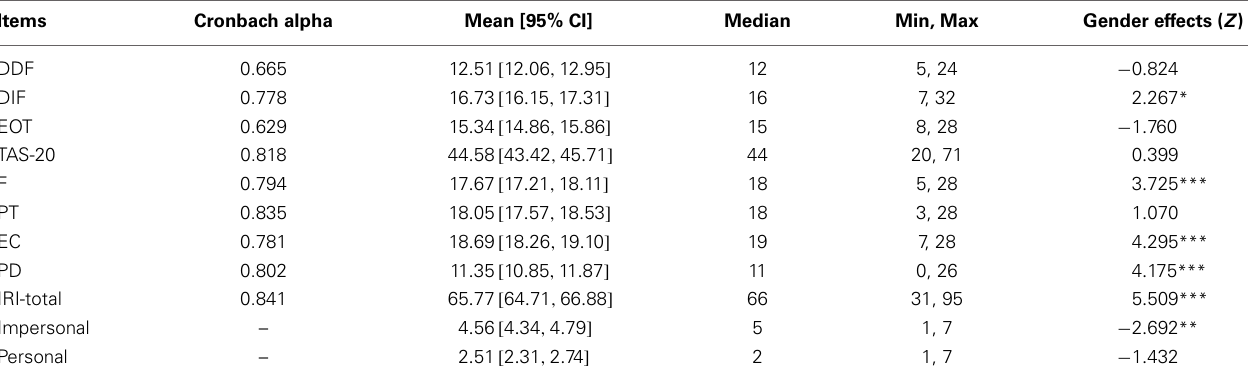
Table 1 | Means with 95% confidence interval values, medians, minimum-maximum spread, gender differences, and Cronbach alphas for alexithymia, empathy scores, and moral dilemma